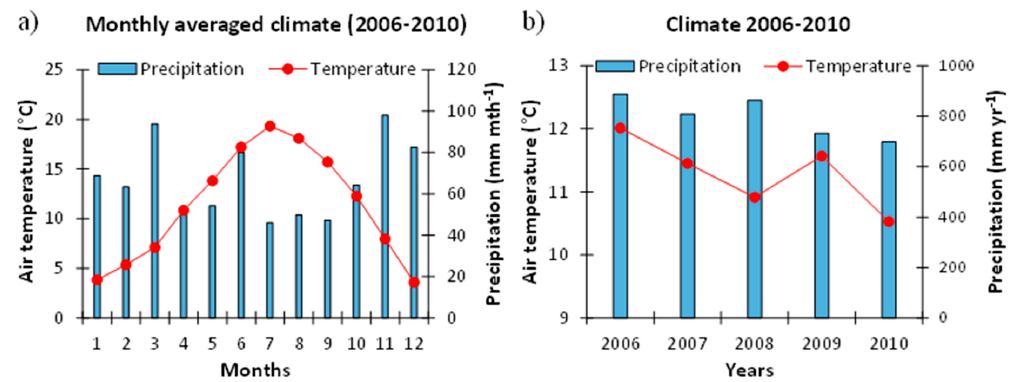
Figure 2. Temporal variation of mean daily air temperature and precipitation over the experimental period (2006–2010) monthly ( a ) and annual ( b ) time scales in Lusignan,